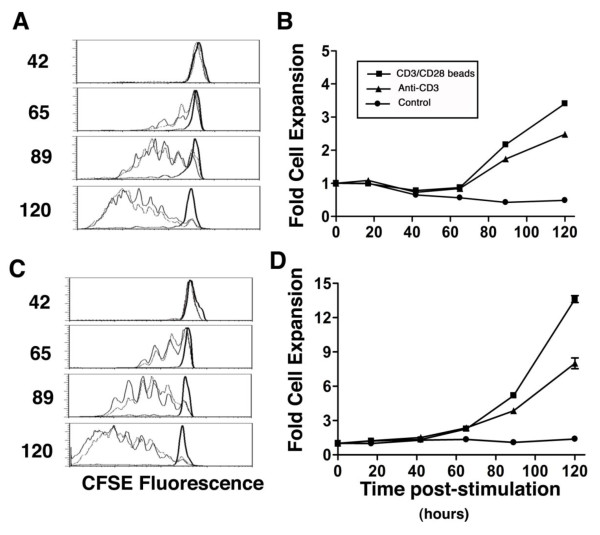
Early time course of T cell division and expansion in response to anti-CD3/CD28 beads and soluble anti-CD3. CFSE-labeled CD4 (A) and CD8 (C) cells began dividing 40-60 hours after exposure to beads (solid lines) or anti-CD3 (dashed lines), but divided minimally in the absence of stimulation (2× solid lines). The number of stimulated and control CD4 (B) and CD8 (D) T cells remained comparable until about 60 hours after stimulation when measureable cell expansion began.